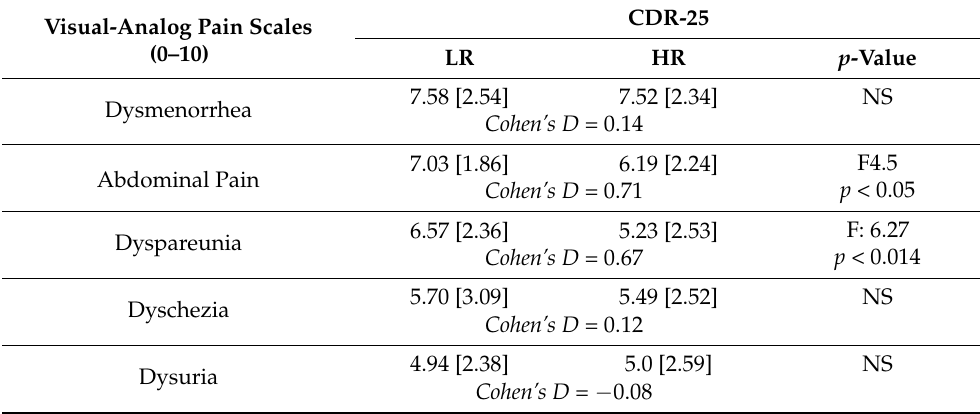
Table 5. Mean scores of the visual-analog pain scales as a function of the resilience level obtained with CDR-25. Low resilience: scores below the first quartile (Q1: 59.75 in CDR-25). High resilience: scores higher than the third quartile (Q3: 80.25 in CDR-25).